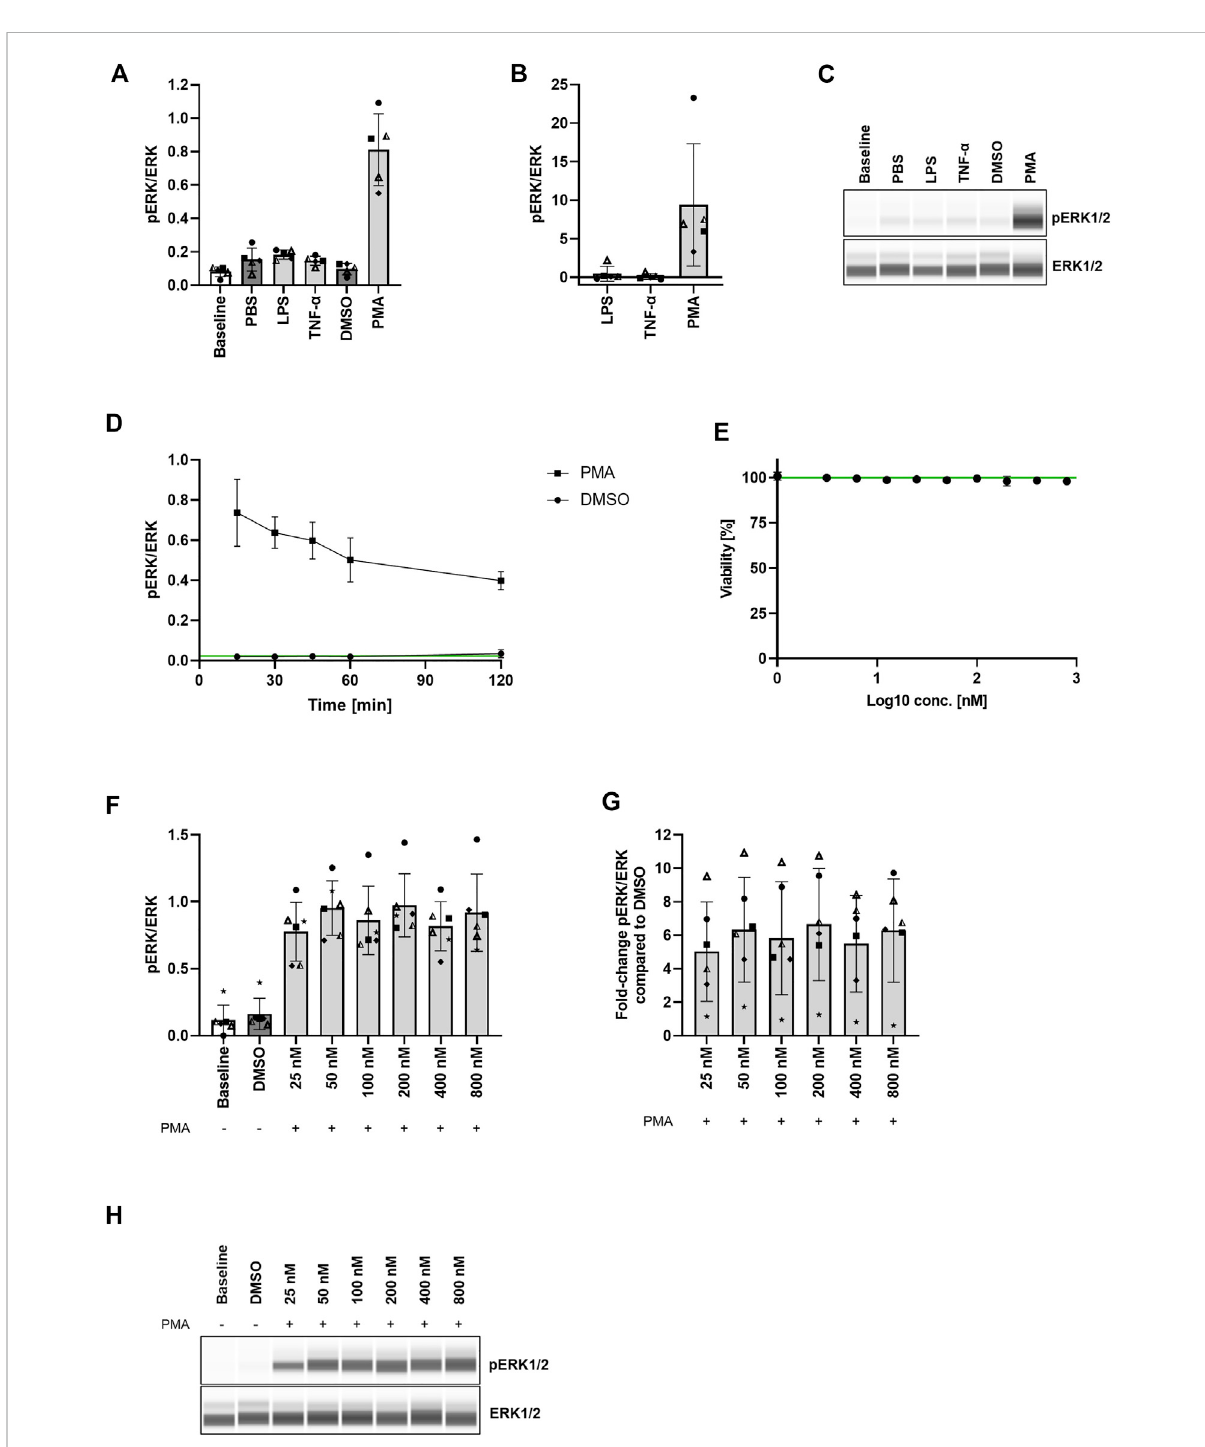
FIGURE 2 Strong MEK1/2 activation without cytotoxic effects in PBMCs after 30 min stimulation with PMA. (A,B) Comparison of ERK1/2 phosphorylation levels in PBMCs after stimulation with LPS, TNF- α , and PMA. PBMCs were stimulated with 1 μ g/ml LPS, 20 ng/ml TNF- α , or 400 nM PMA. The cells were puri fi ed, lysed, and the ERK1/2 phosphorylation status was assessed with the Wes ™ system. Data are presented as individual values and mean with standard deviation. Each datapoint represents one blood donor. N = 5 blood donors. (C) Presentation of pERK1/2 and ERK1/2 levels as Western blot-like bands of one representative blood donor included in (A,B) . The Western blot-like band data of all blood donors is shown in the Supplementary Material. (D) PMA stimulation timeline. PBMCs were stimulated with 400 nM PMA for 15 – 120 min, the cells were puri fi ed, lysed, and theERK1/2phosphorylationstatuswasassessedwiththeWes ™ system.Dataarepresentedasmeanwithstandarddeviation. N =3blooddonors. (E)